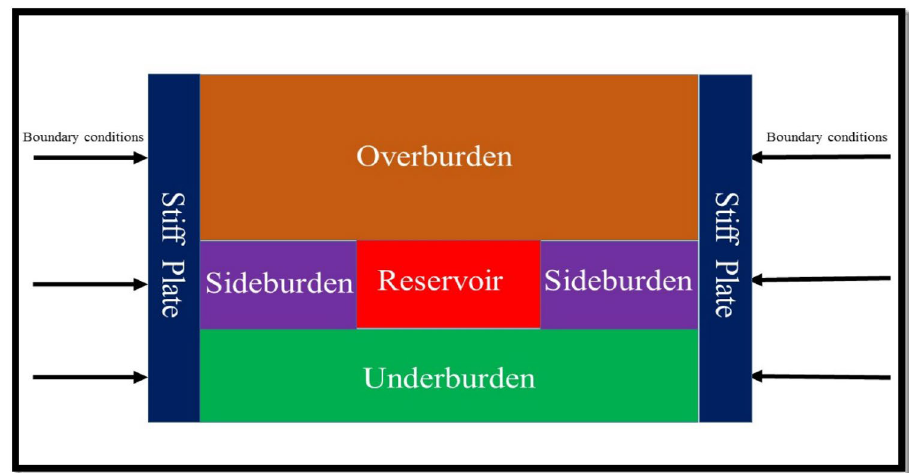
Fig. 9 Geomechanical grid parts